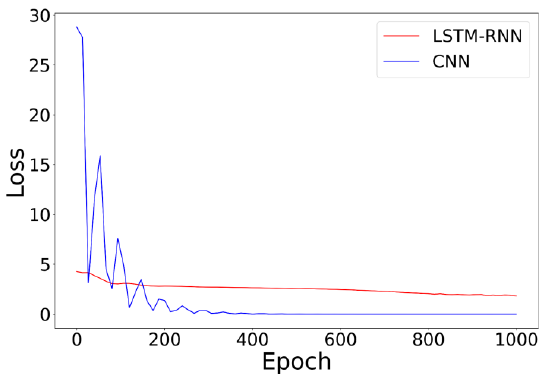
Figure 3. The loss curves of the LSTM-RNN and CNN models.